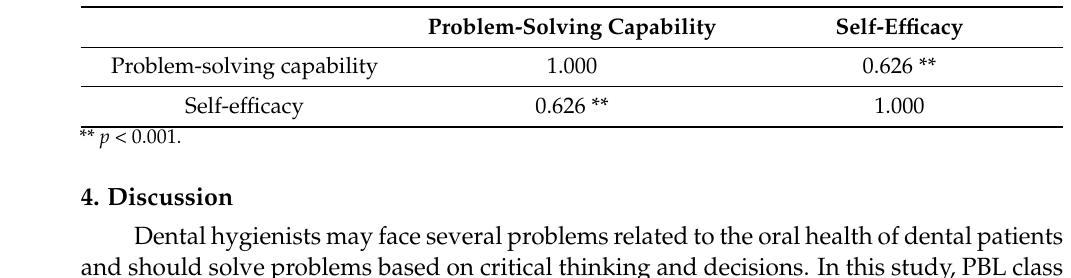
Table 3. Correlation between problem-solving ability and